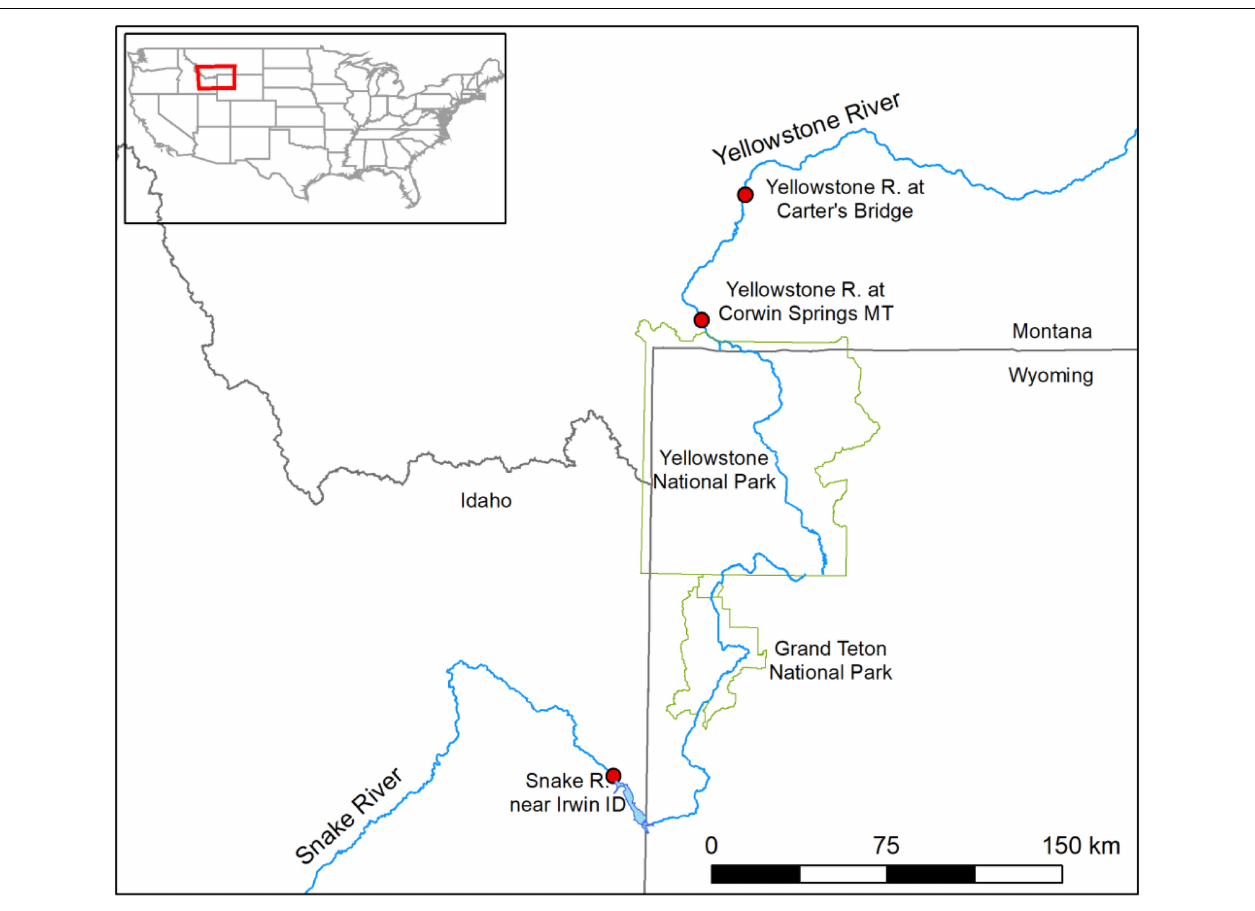
FIGURE 2 | Map of ESP water sampling locations. The red box in the inset map shows the location of the Upper Yellowstone River and Upper Snake River in the United States. The larger map shows the sample site locations (filled red circles) on each river relative to Yellowstone National Park and Grand Teton National Park (outlined in